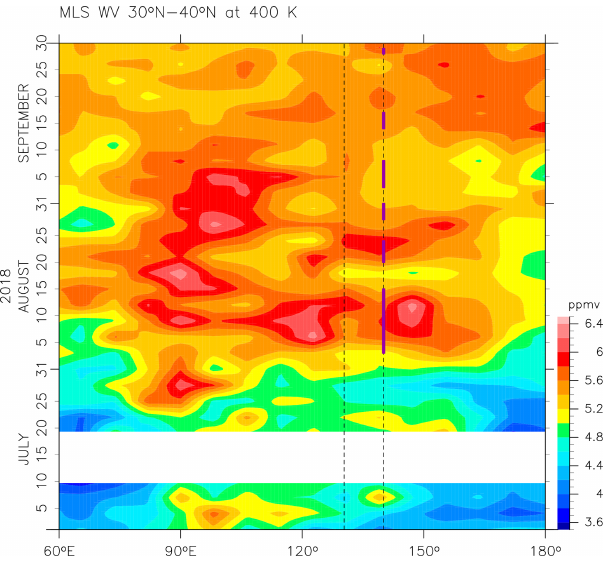
Figure 8. As for Fig. 7, but for water vapour (in ppmv) at 400K measured with the satellite MLS instrument. Data for the 30–40 ◦ N region have been aggregated into 3d and 8 ◦ longitude bins, each constituting about 10 individual data points. The white region indi- cates missing measurements. The purple line segments are the same as the orange ones in Fig. 7.